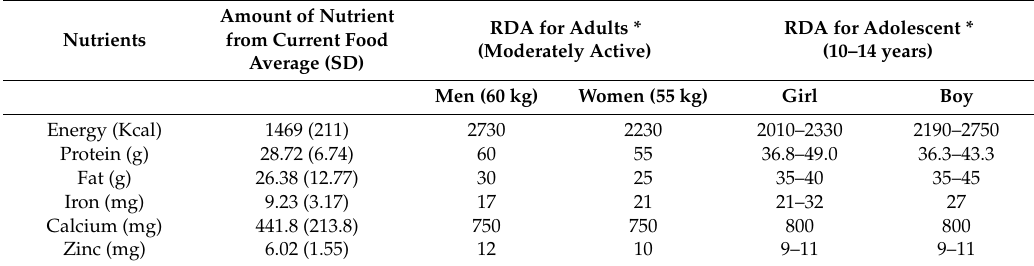
Table 4. Estimated average per capita macro and important micronutrient intake of the based on household dietary assessment in comparison to RDA for adults and adolescents.